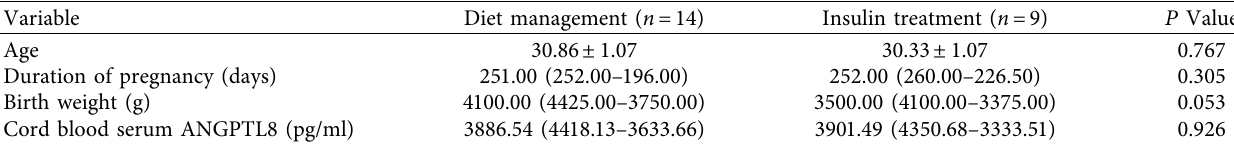
Table 4: Treatment effects of diet management and insulin treatment in pregnant subjects with diabetes mellitus. Variable